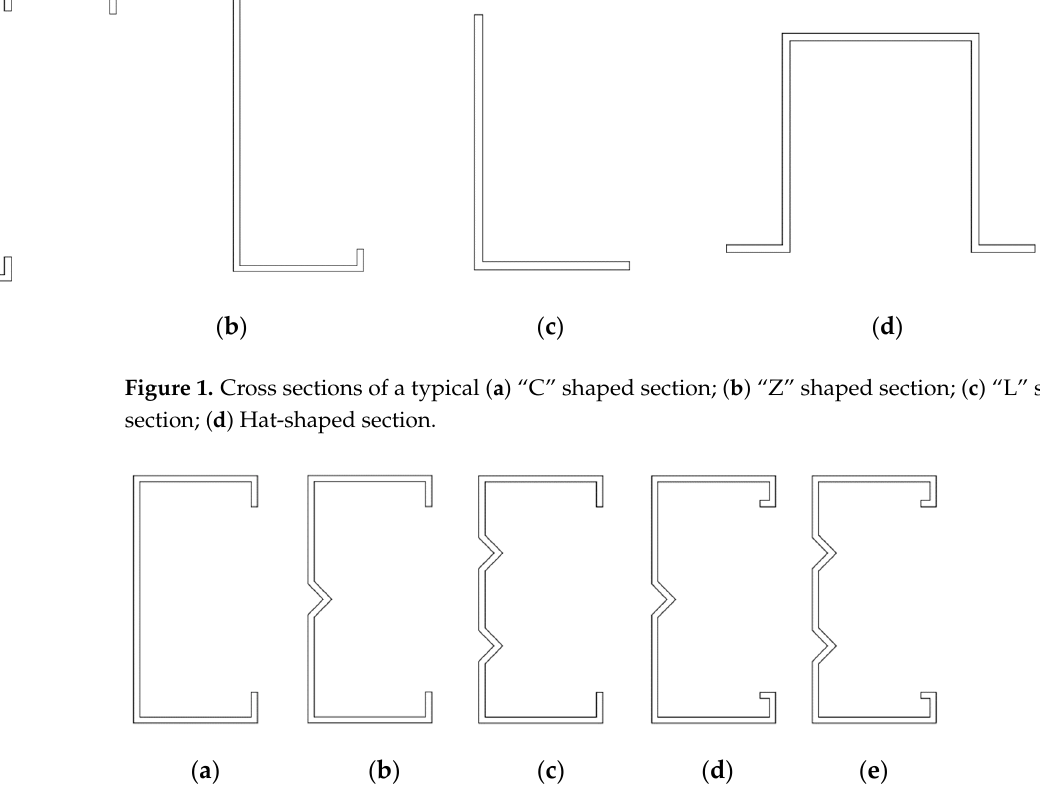
Figure 2. Different cross-sections of ( a ) A simple lipped channel; ( b ) A lipped channel with one web stiffener; ( c ) A lipped channel with two web stiffeners; ( d ) A channel section with one web stiffener and return lips; ( e ) A channel section with two web stiffeners and return lips.